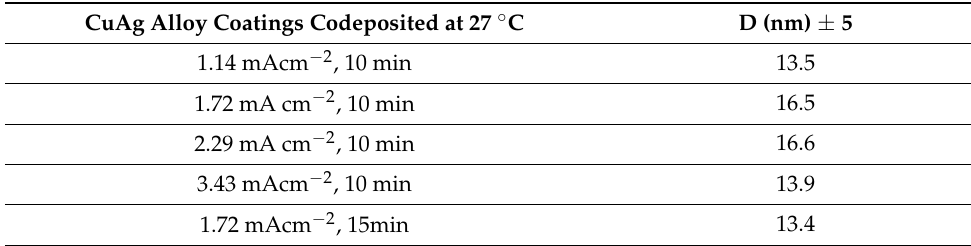
Table 2. Crystallite size of the ncCuAg determined using XRD analysis.